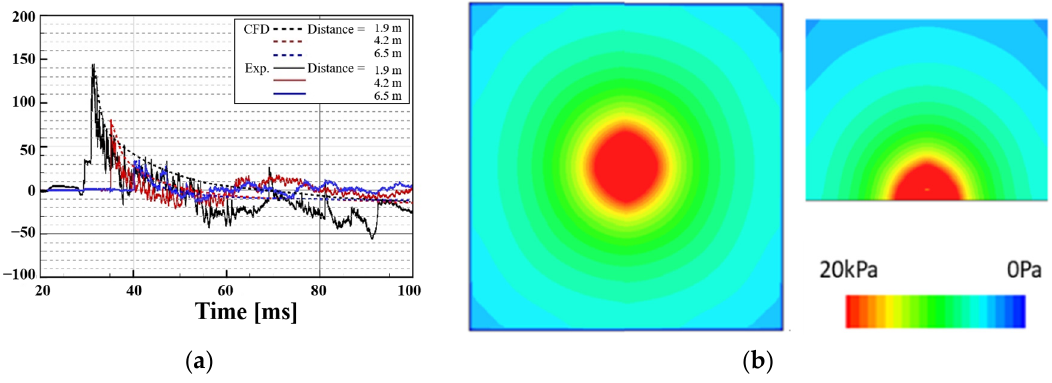
Figure 11. Simulation results for a hydrogen explosion in a semi-enclosed space: ( a ) pressure profile; ( b ) pressure contours—floor plane ( left ) and vertical plane ( right ).